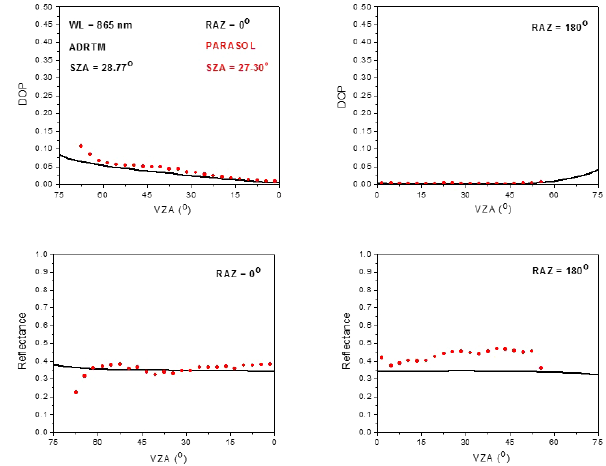
Figure 12. Same as in Fig. 11 but at RAZs of 90 and 270 ◦ .